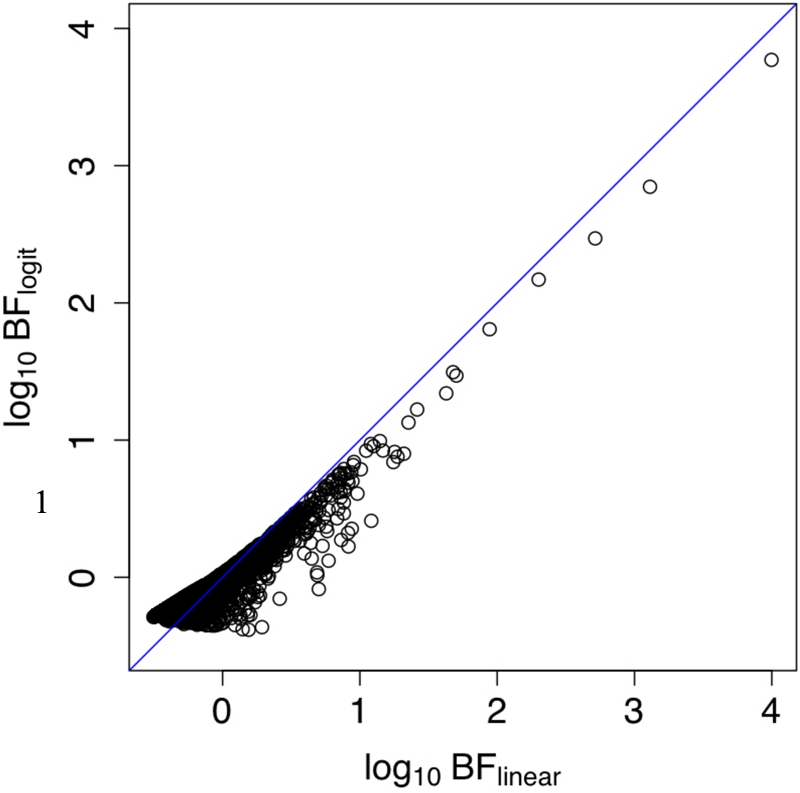
The x-axis is log10 (BF) of linear model and y-axis is log10
BF of logistic model.The blue line is x = y.